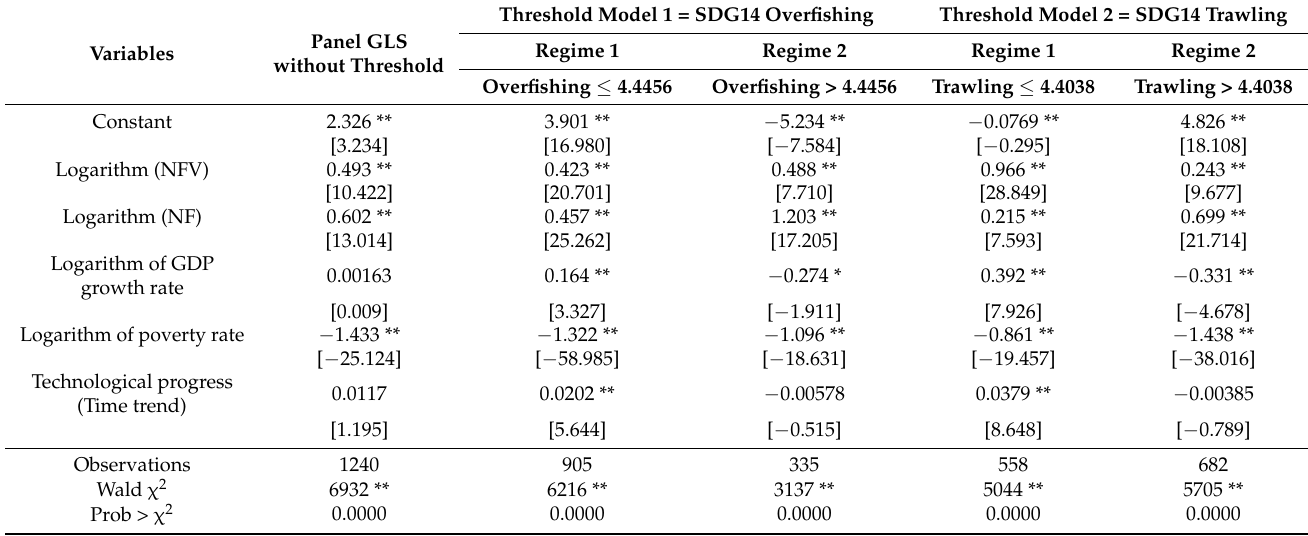
Table 7. Regression results using different threshold variables after adding country control variables (GDP growth rate and poverty rate). Dependent variable: global fishery